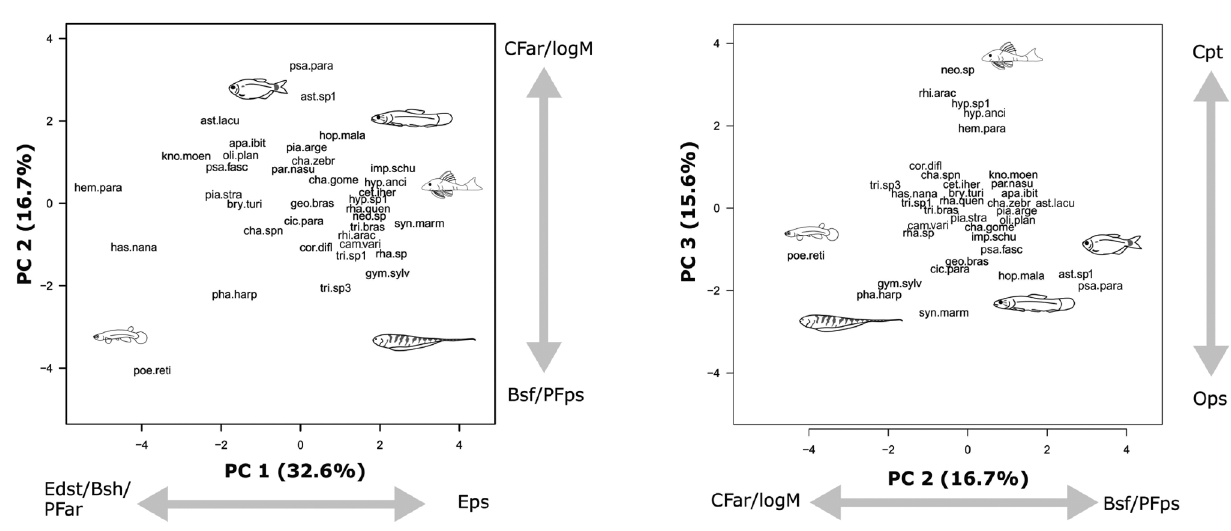
FIGURE 5 | Ecomorphological space showing the position of each fish species (36) from the Araguari River basin. Each plot represents two axes of a principal component analysis (PCA), where species are plotted according to their respective trait values. Codes at the ends of the arrows are the most important ecomorphological traits for each PCA axis. For trait and species codes, see Tab. 2 and Tab. S3 ,